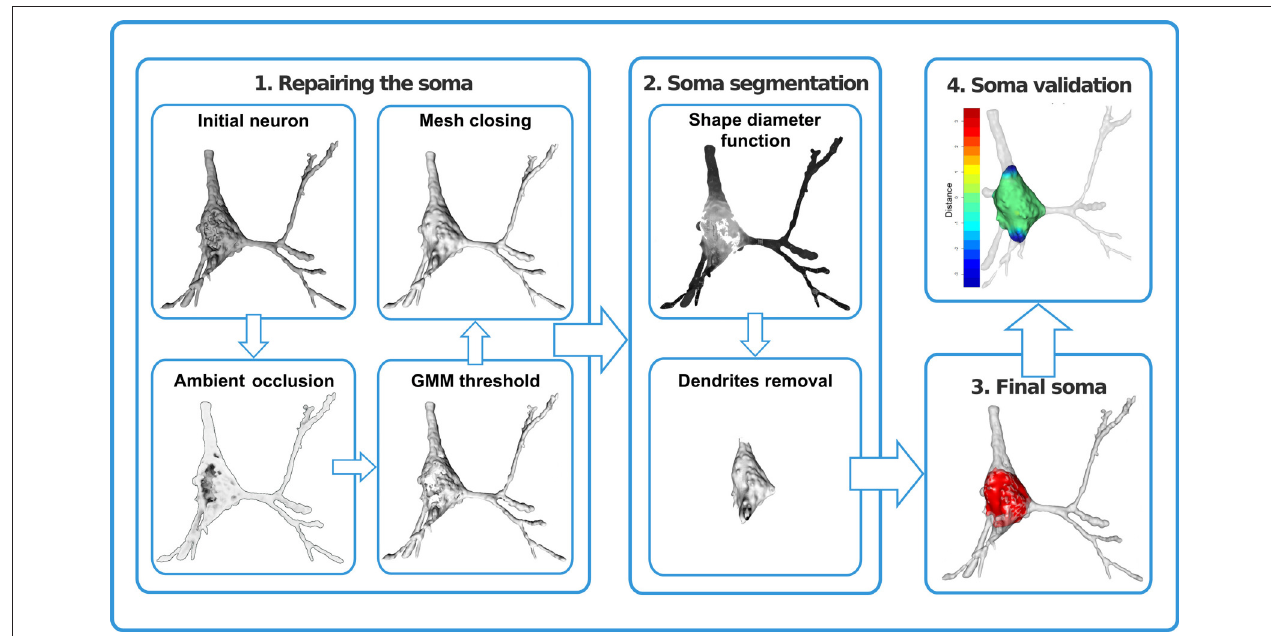
FIGURE 1 | Repair and segmentation process workflow. The process was divided into four modules. First, the neuron was repaired by removing holes and cavities and closing the mesh. Second, dendrites were identified and removed. As a result, the neuronal cell body was defined (third module) and was validated (fourth module) by means of distance computations and volume